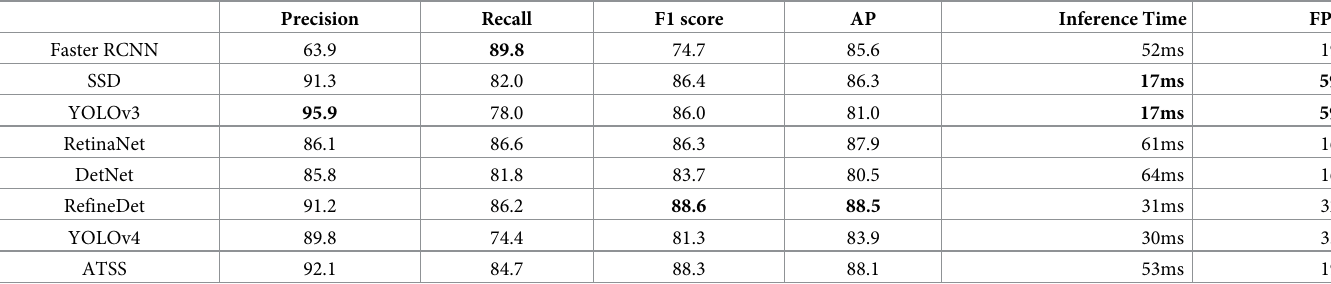
Table 5. Result for frame-based one-class polyp detection.